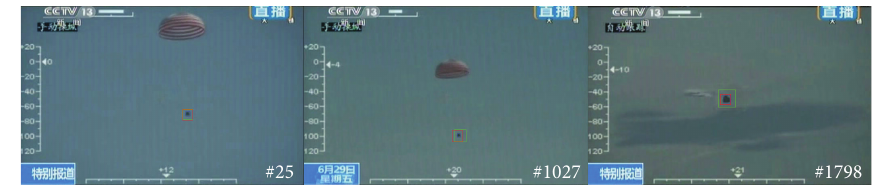
Figure 5: Tracking snapshots of Shenzhou IX. True value, the result of TLD, and the result of AA-TLD are, respectively, marked with blue box, green box, and red